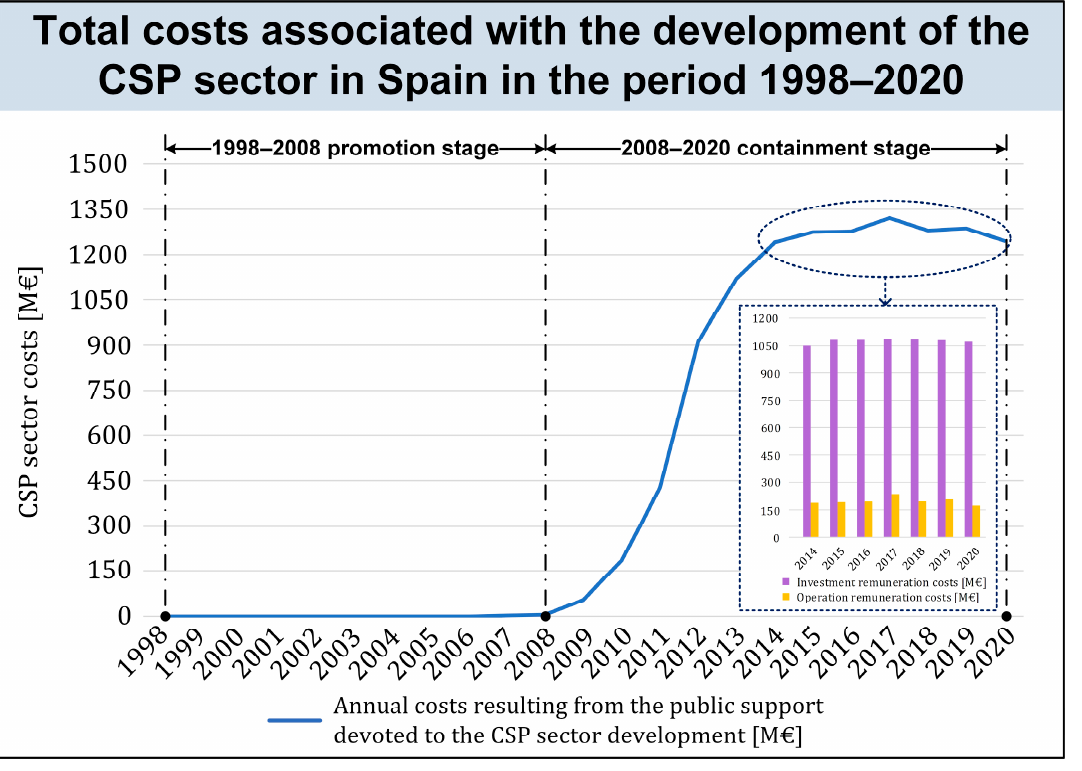
Figure 5. Evolution of the annual costs associated with the Spanish CSP sector development in the period 1998–2020. Source: self-elaboration based on [69].